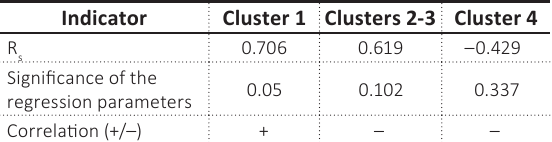
Table 5. Correlation between indicators of the quality of higher education and expenditures per student within